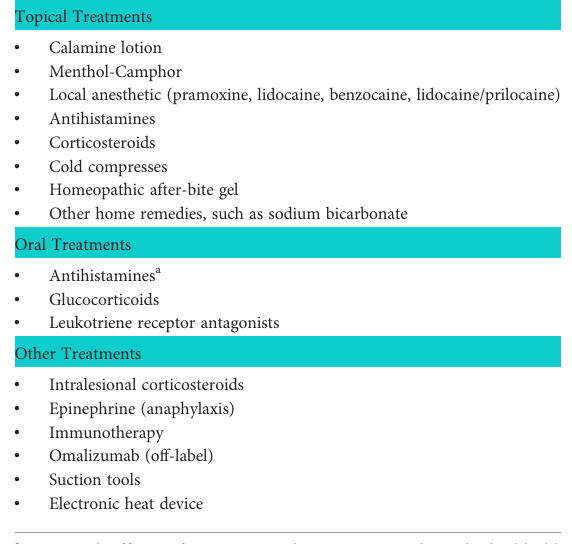
TABLE 2 Second-line mosquito bite